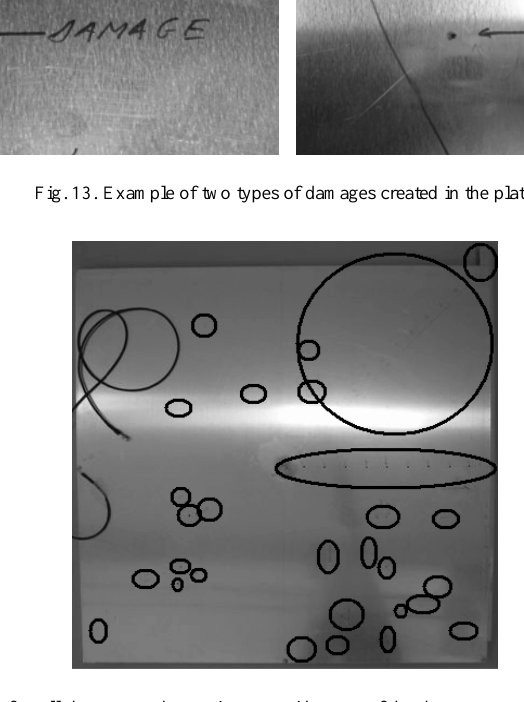
Fig. 14. Aluminum plate after all the executed experiments, with some of the damages marked (including a rivet hole